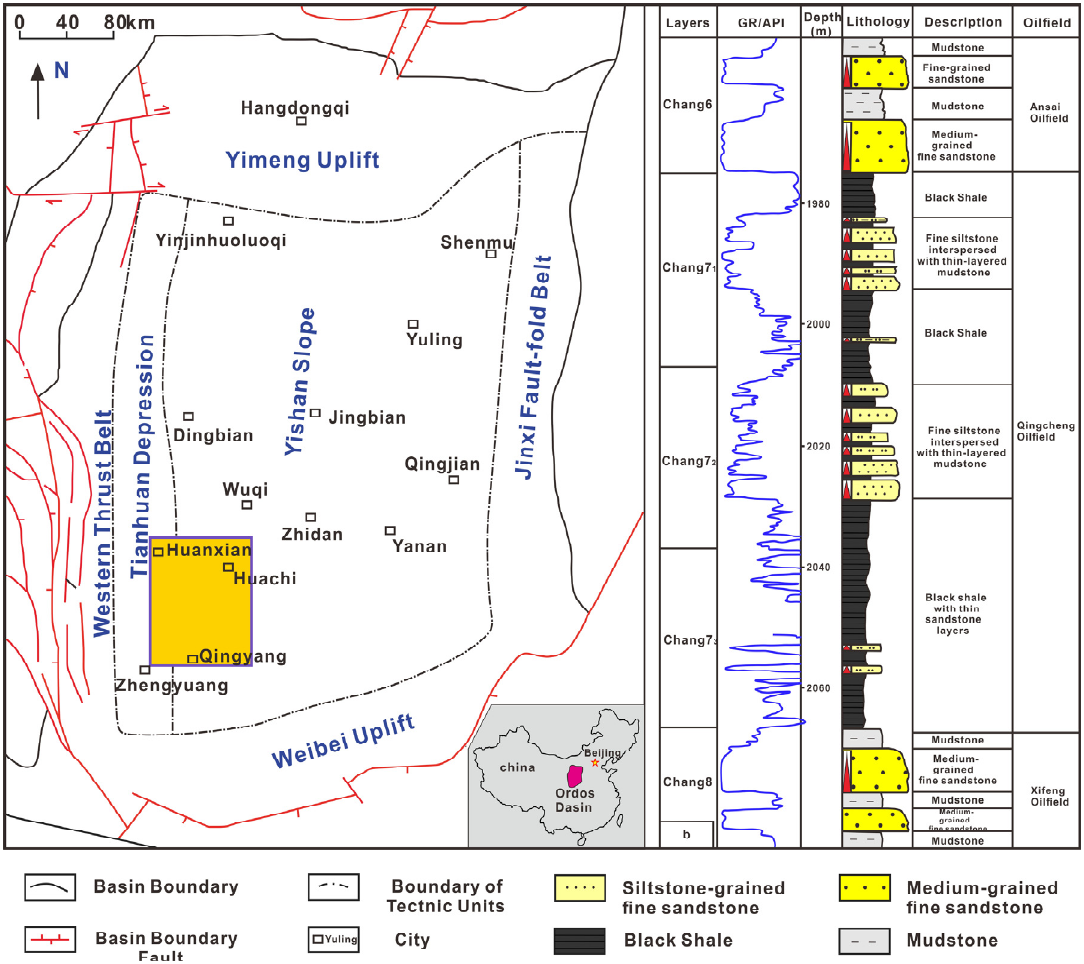
Figure 1. Geological tectonics of the Longdong area. The Chang 7 member of the Yanchang Formation represents the maximum expansion period of the lake basin during most active basin deposition. More than 80% of the